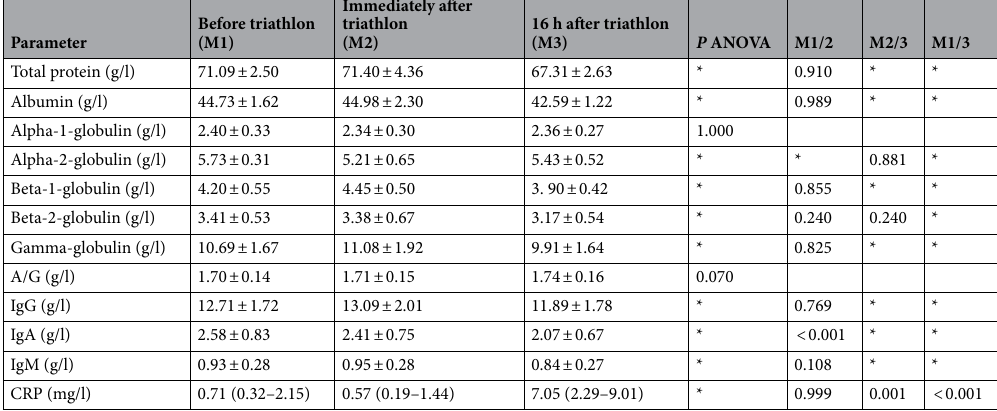
Table 9. Mean values (± SD) or medians (IQR) of selected serum protein parameters in the 3 performed measurements (M). *Significant difference ( P < 0.05). IQR interquartile range, A/G albumin/globulin ratio, CRP C-reactive